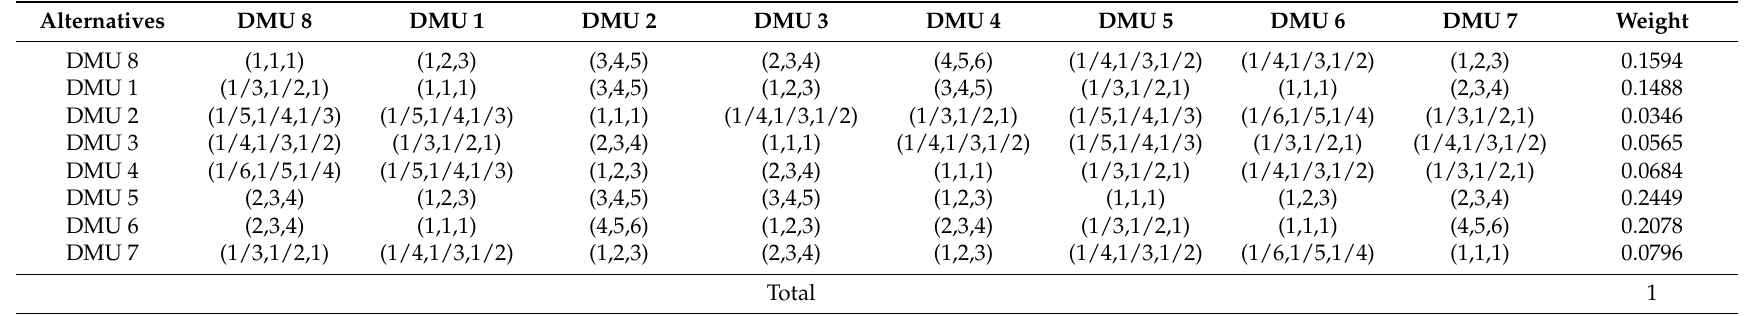
Table A34. Comparison matrix for TEM based on